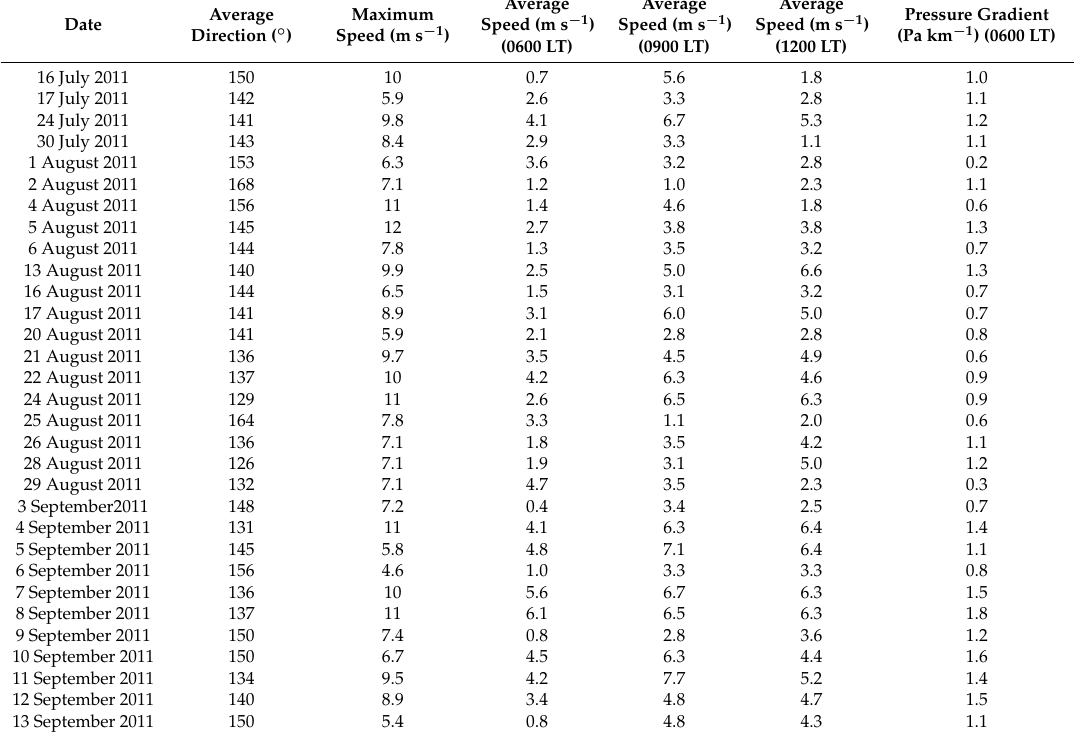
Table 1. Wind speed and direction measured at NM3 and calculated sea level pressure gradients from the ERA-Interim reanalysis during gap wind event days. NM3 was located on the north canyon wall about one-third of the way up. Average direction and maximum speed are reported for 0500–1200 LT. Average speeds are wind speeds averaged over the specified hour. Maximum speeds are the maximum instantaneous speeds observed (30-s